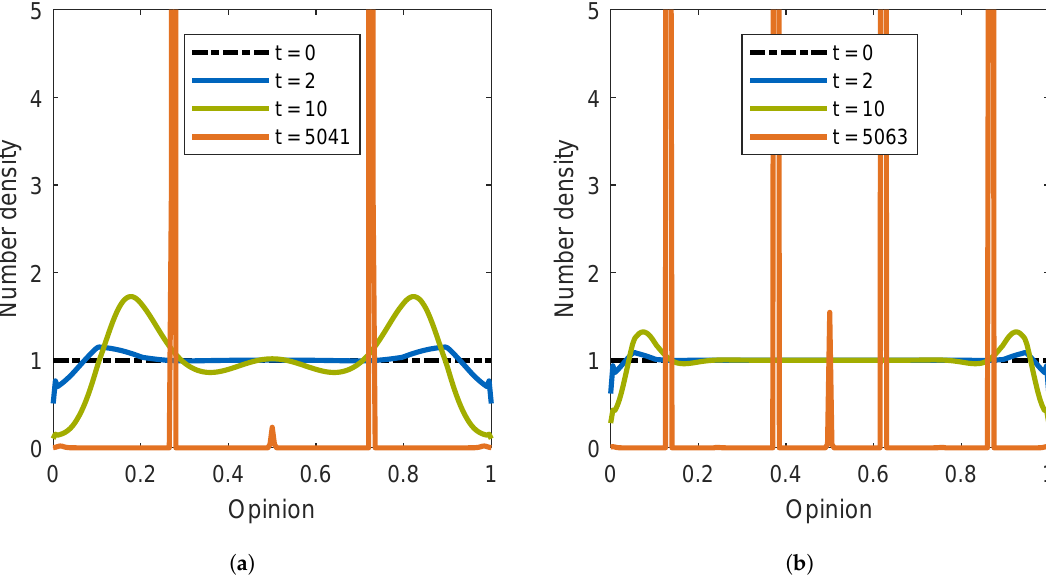
Figure 3. Time evolution of number density n of opinions for convergence parameter µ = 0.5; results shown for bounded confidence parameter d = 0.2 ( a ) and d = 0.1 ( b